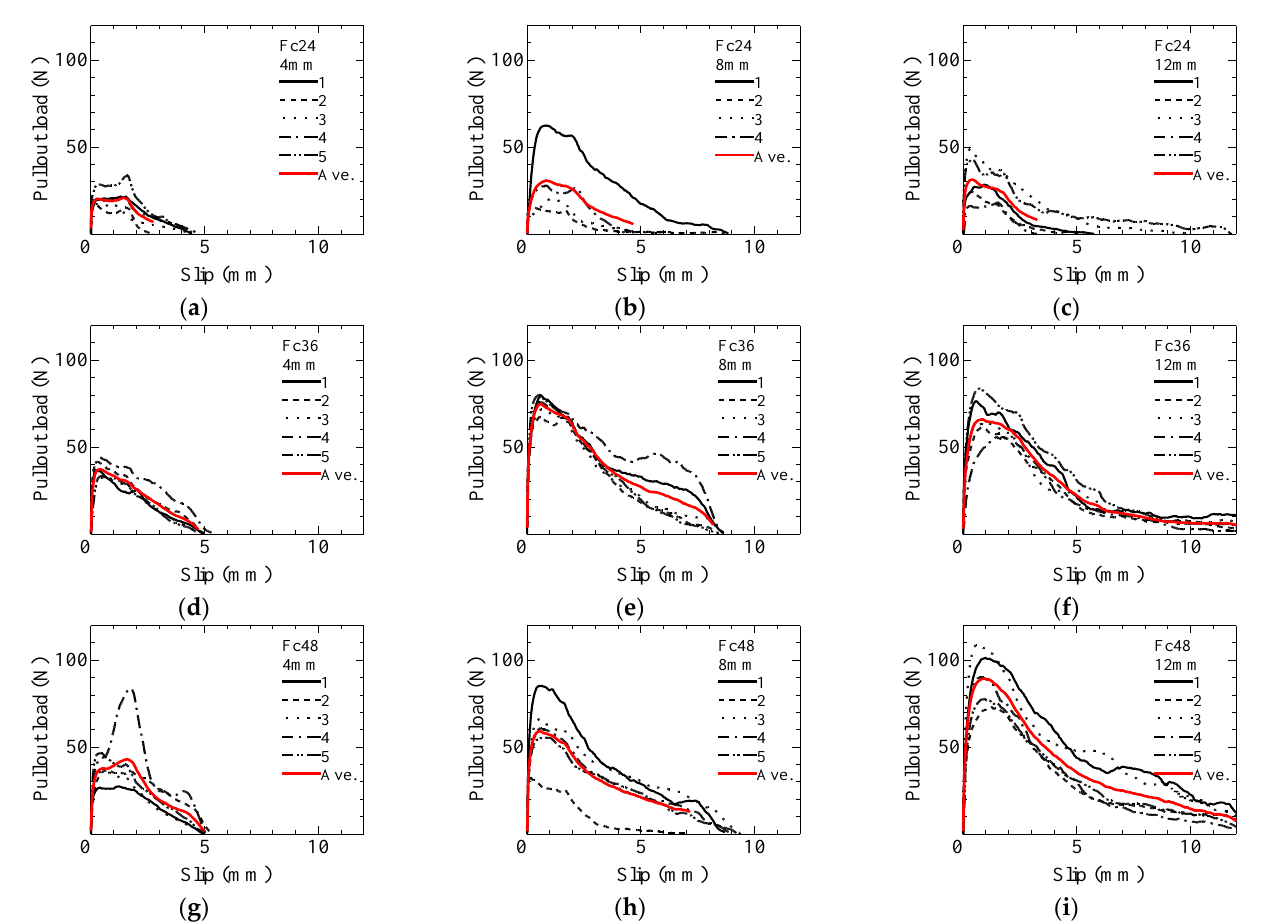
Figure 12. Pullout load-slip relationship in pullout test: ( a ) Fc24-4 mm; ( b ) Fc24-8 mm; ( c ) Fc24-12 mm; ( d ) Fc36-4 mm; ( e ) Fc36-8 mm; ( f ) Fc36-12 mm; ( g ) Fc48-4 mm; ( h ) Fc48-8 mm; ( i ) Fc48-12 mm.